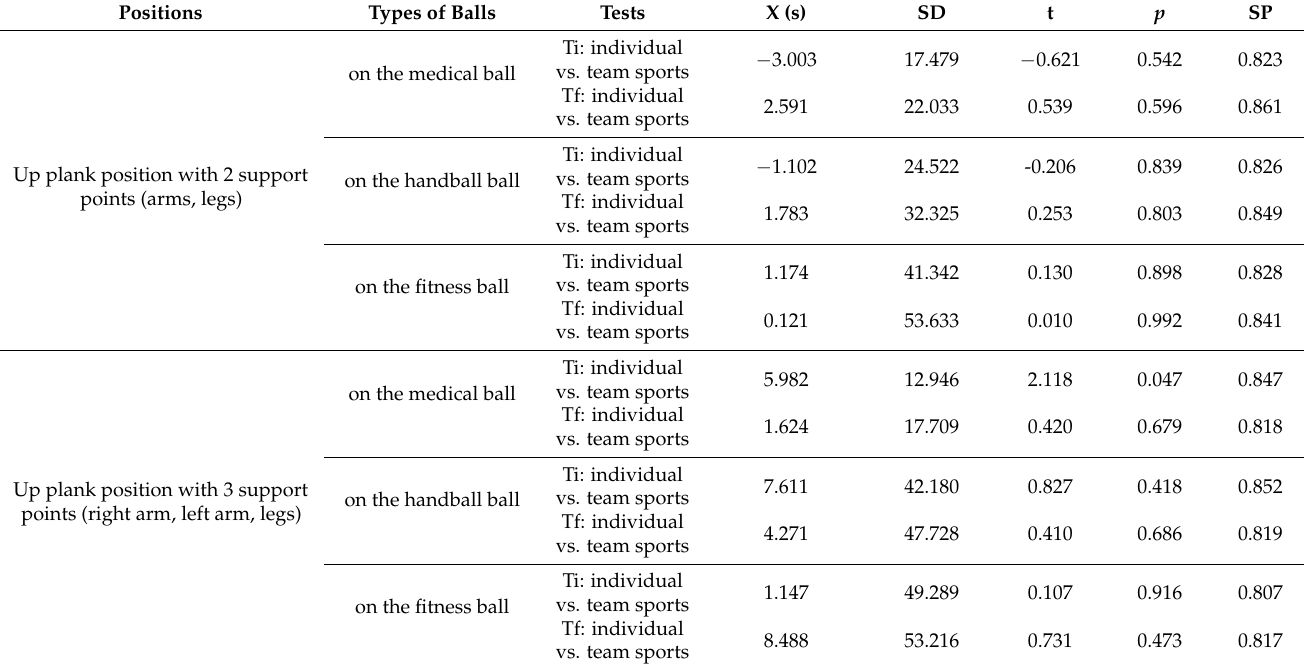
Table 5. Descriptive statistics for physical tests of maintaining balance on the three types of balls in the up plank position. Positions Types of Balls Tests X (s) SD t p SP Ti: individual vs. team on the medical ball